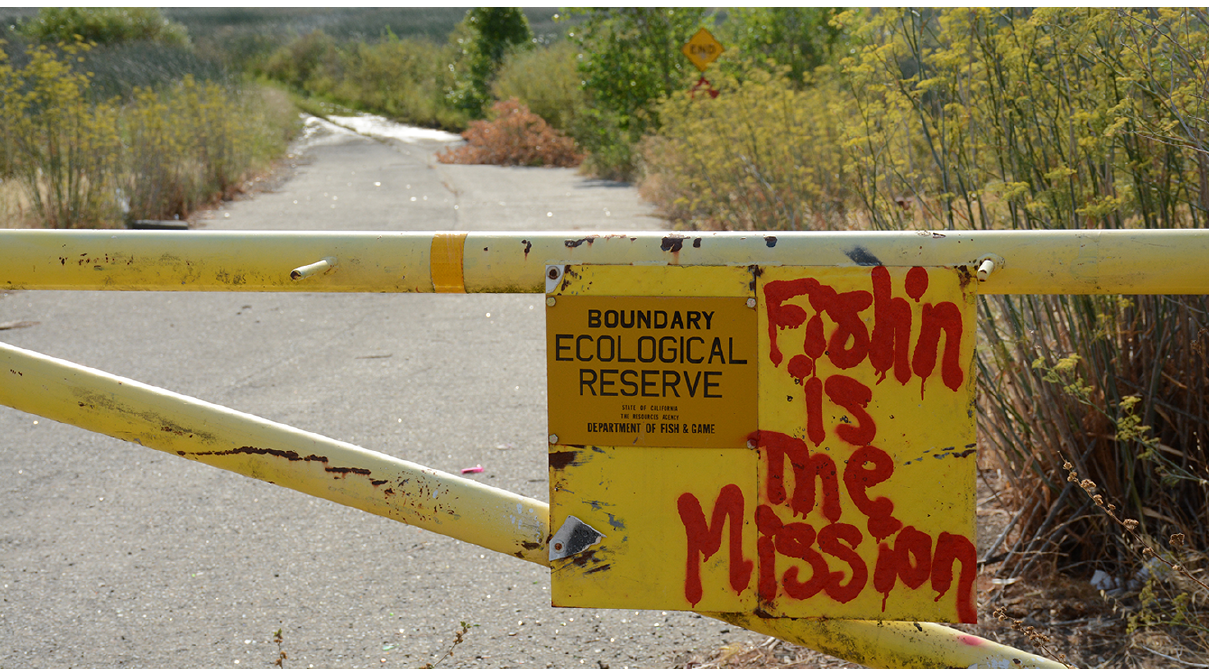
Figure 7. Entrance sign to Liberty Island, Summer 2015, revealing different conceptions and uses of the landscape. Image by Brett